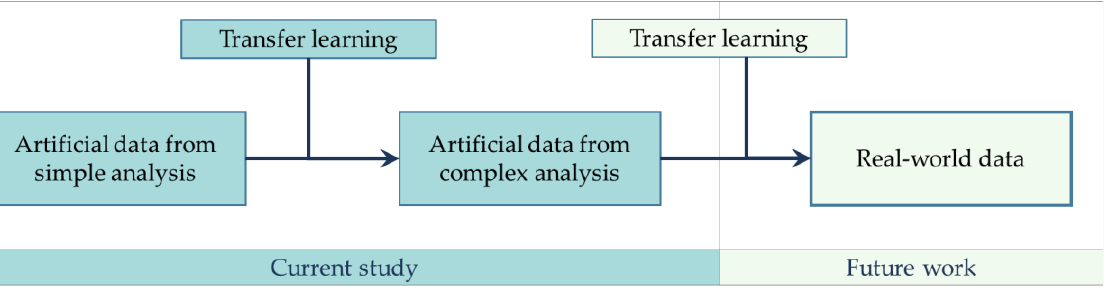
Figure 2. Illustration of the potential of the current study for future application to real-world settings.